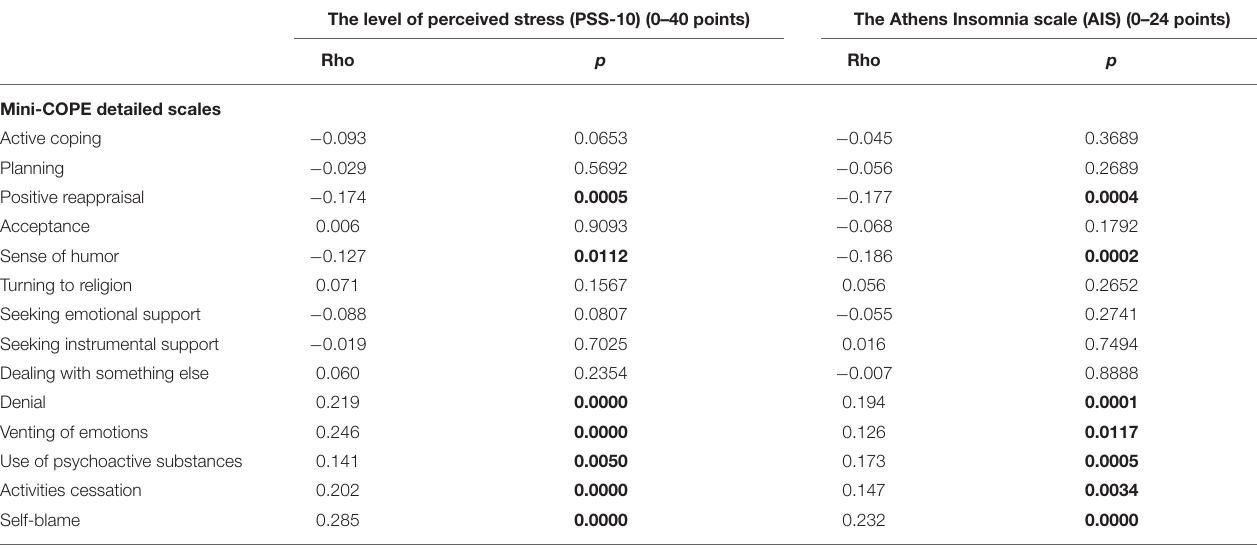
TABLE 2 | The level of perceived stress and sleep disorder and coping with stress of nursing students. The level of perceived stress (PSS-10) (0–40 points) The Athens Insomnia scale (AIS) (0–24 points) Rho p Rho